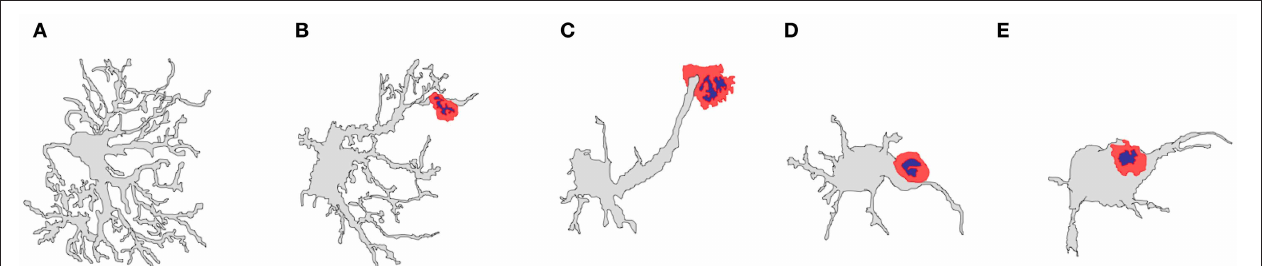
FIGURE 6 | Diagrams representing the shape variation that can be found in T-cell–astrocyte interactions in the rat striatum. Adenovirus-infected astrocytes display different shapes as the T-cell apposition become closer to the astrocyte cell body. (A) Typical astrocytic shape in the brain; (B) an astrocyte in contact with a T-cell lymphocyte (red) at its terminal processes;